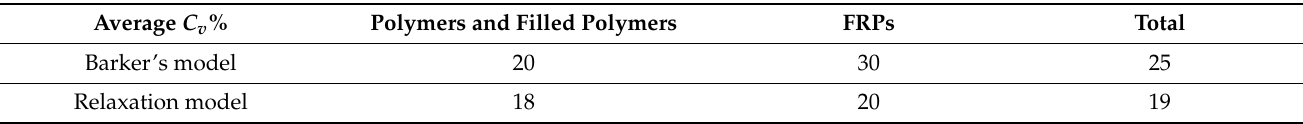
Table 3. Results of calculation of models’ average C v